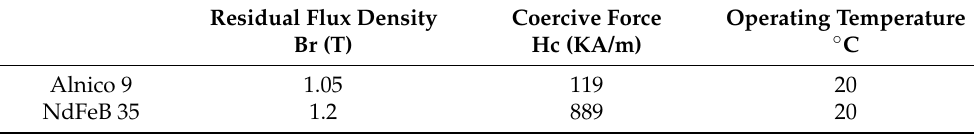
Table 1. Magnetic properties of the